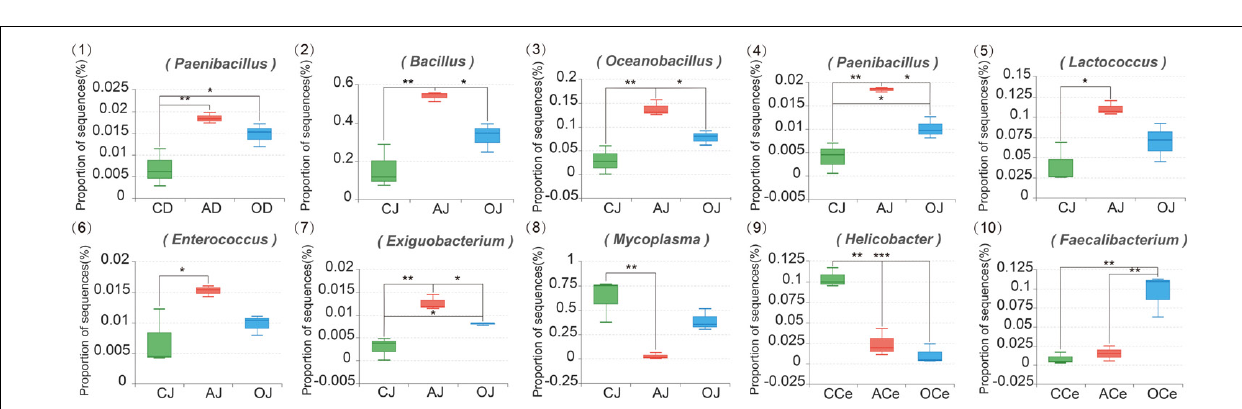
FIGURE 4 | The Composition Analysis of Microbiota Community at the Genus Level. CD, AD, and OD: duodenum mucosal microbiota of control group, alfalfa meal group, and commodity concentrated fiber group, respectively. CJ, AJ, and OJ: jejunum mucosal microbiota of control group, alfalfa meal group, and commodity concentrated fiber group, respectively. CI, AI, and OI: ileum mucosal microbiota of control group, alfalfa meal group, and commodity concentrated fiber group, respectively. CCe, ACe, and OCe: cecum mucosal microbiota of control group, alfalfa meal group, and commodity concentrated fiber group, respectively. CCo, ACo, and OCo: colon mucosal microbiota of control group, alfalfa meal group, and commodity concentrated fiber group, respectively. CF, AF, and OF: feces mucosal microbiota of control group, alfalfa meal group, and commodity concentrated fiber group, respectively. ∗ 0.01 < P < = 0.05, ∗∗ 0.001 < P < = 0.01, ∗∗∗ P < =